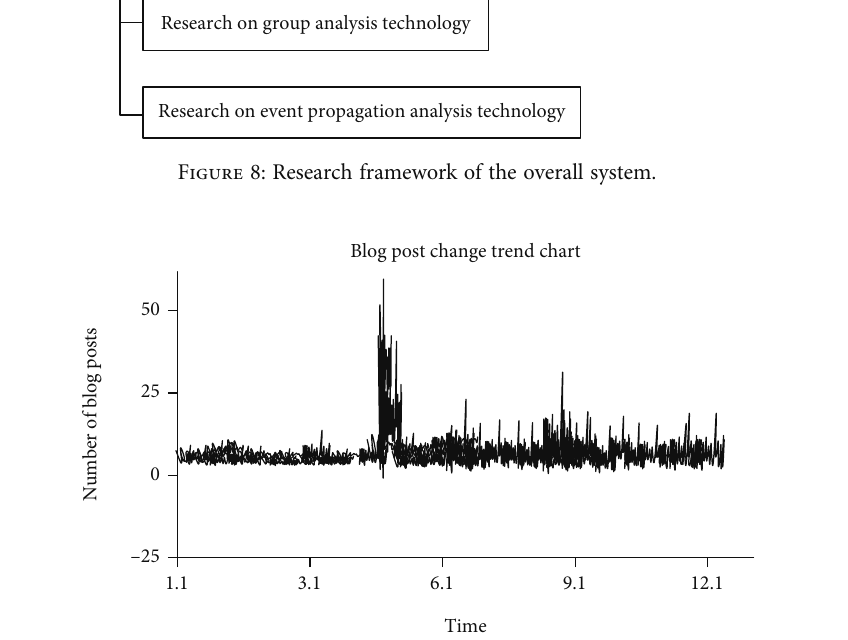
Figure 9: Trend graph of blog